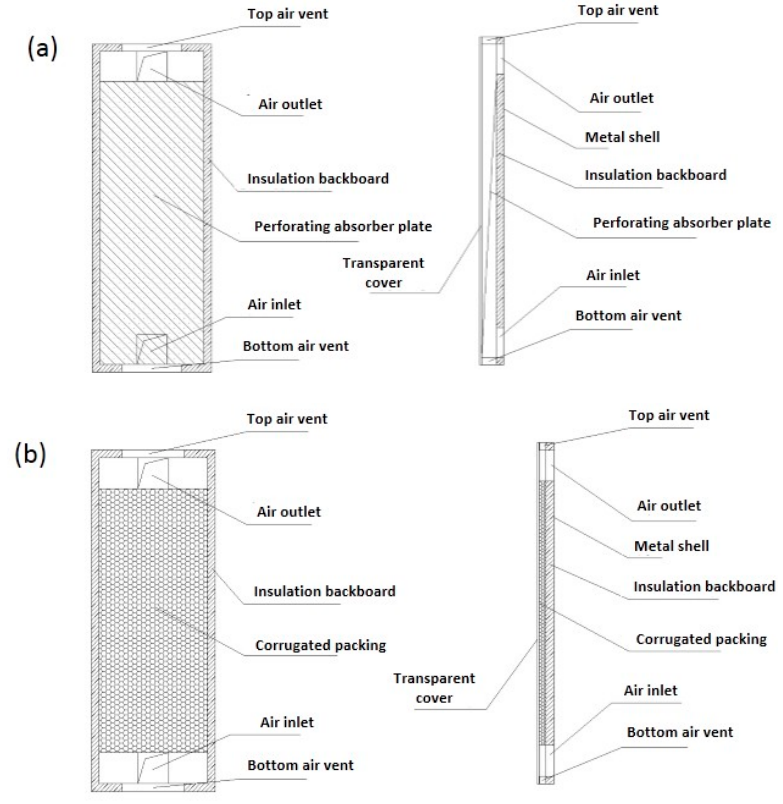
Figure 1. Schematic diagram of glazed transpired solar air collector with ( a ) slit-perforated plate and perforating corrugated plate and ( b ) metal corrugated packing.